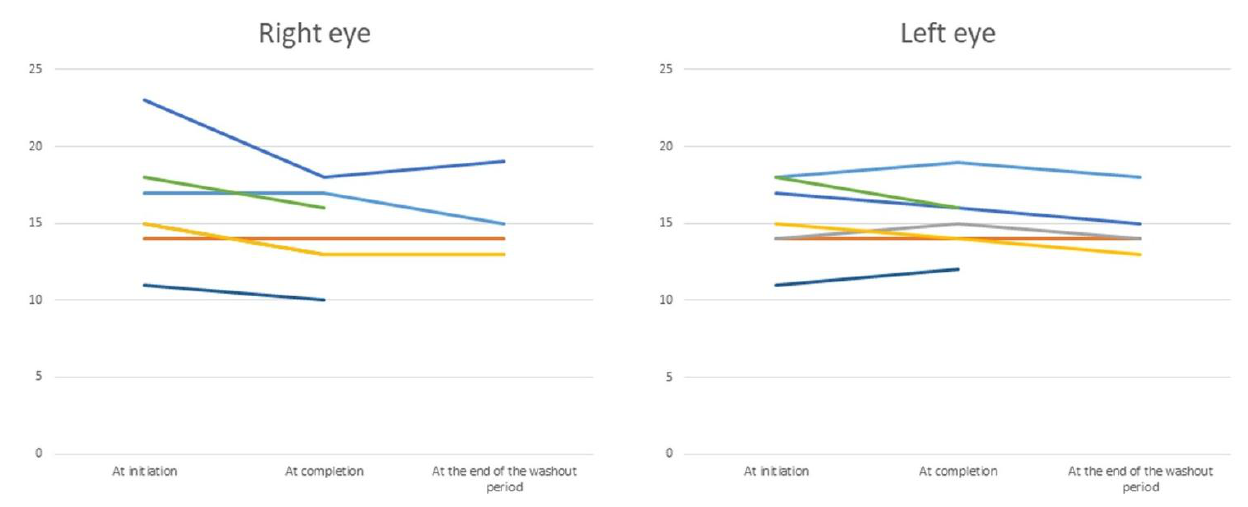
Figure 2 : Assessment of QOL by the JACQLQ. Seventeen items from 6 domains (daily life, outdoor life, social life, sleep, body, and mental life) were scored from 0 to 4, and the total score was calculated. (0: None, 1: Mild, 2: Moderate, 3: Severe, 4: Very severe). Improvement of the QOL scores was observed after treatment (p=0.0625, Wilcoxon signed rank test). There was no deterioration of QOL after discontinuation of treatment.